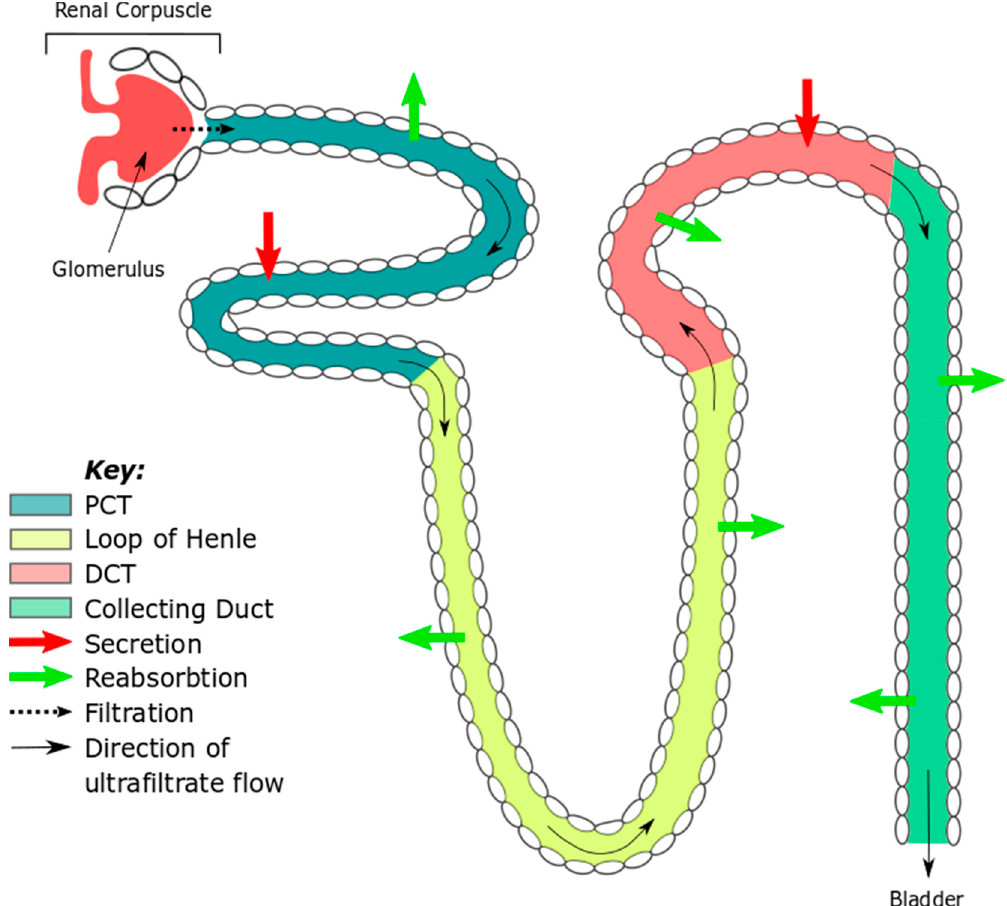
Figure 1. The nephron—the functional unit of the kidney. A different color is used to highlight each nephron domain. The direction of ultrafiltrate flow is shown with black arrows, bold arrows signify secretion of waste products (red) and solute reabsorption (green). PCT, proximal convoluted tubule; DCT, distal convoluted tubule.